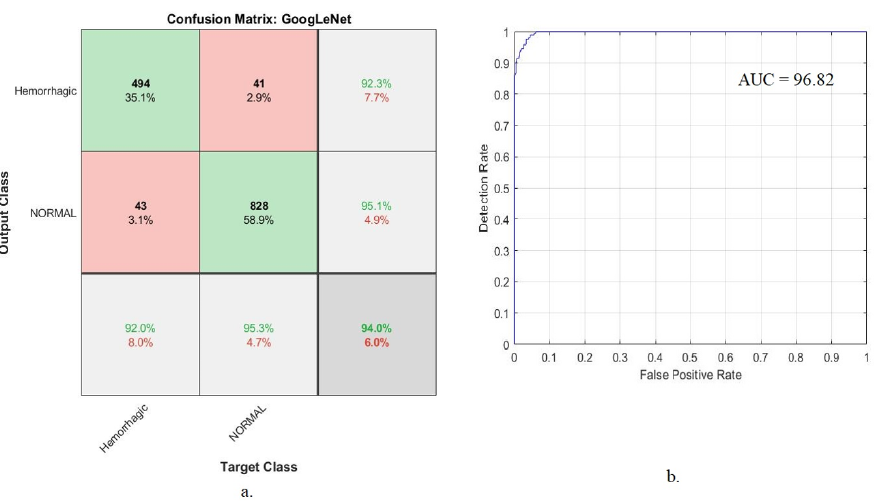
Figure 8. Performance of the GoogLeNet model for diagnosing hemorrhage dataset. ( a ) Confusion matrix. ( b )